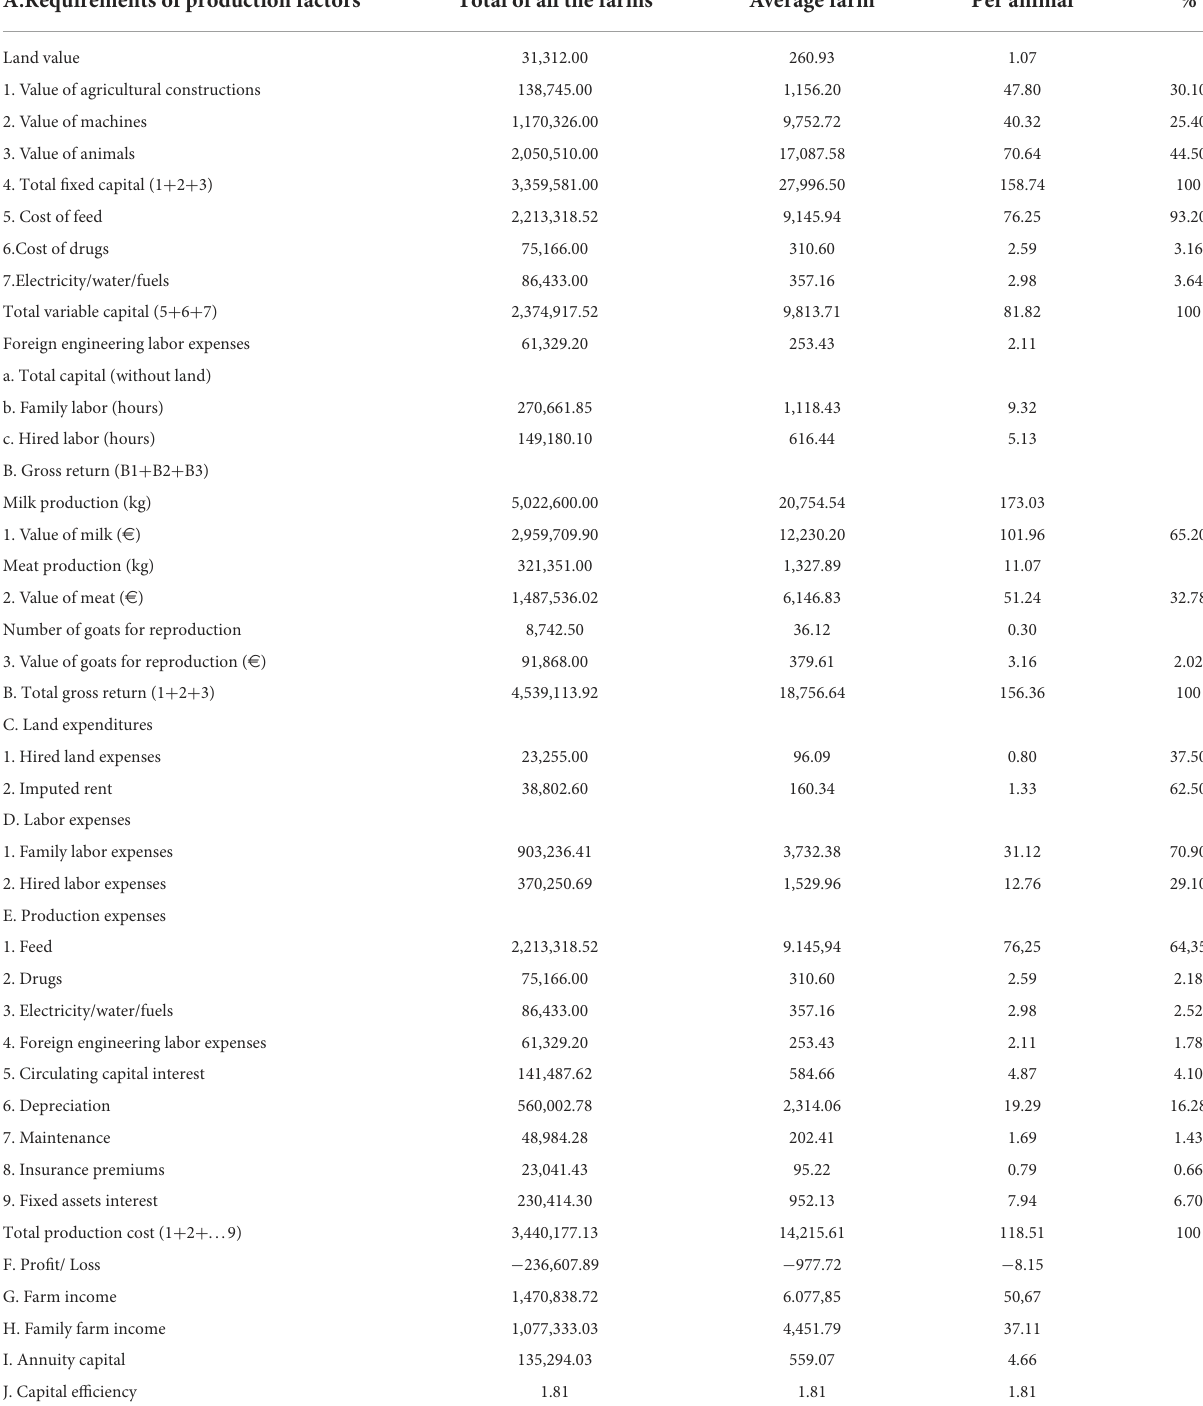
TABLE 6 Summary table of financial results of goat